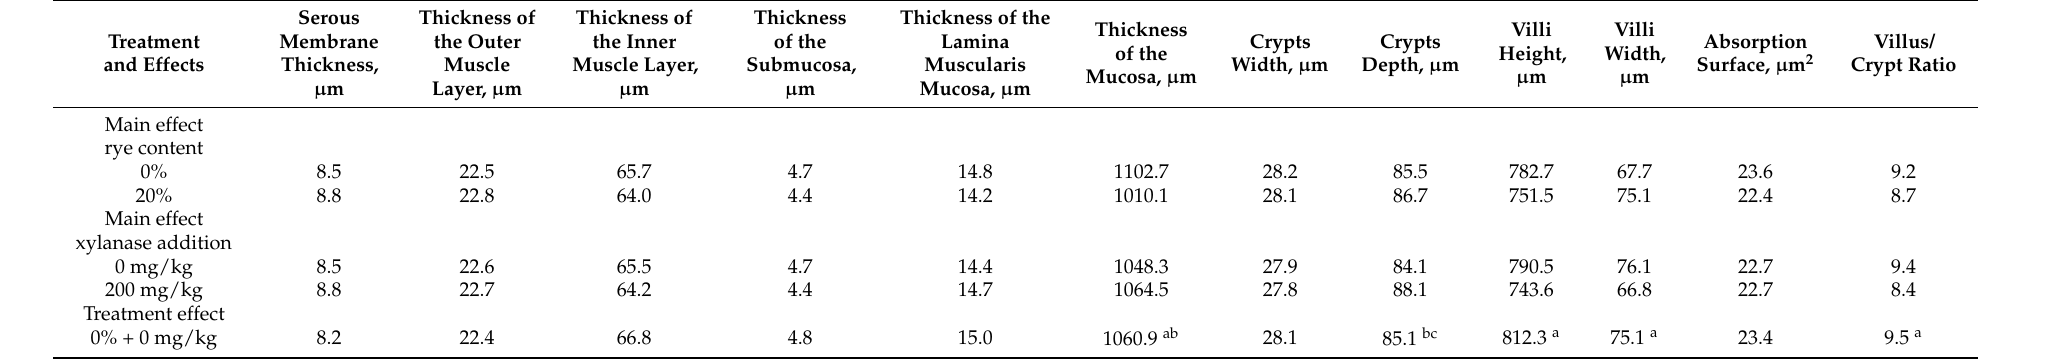
Table 4. Histomorphometric properties of the jejunum of male, Ross 308 broiler chicks following the 42-day experimental